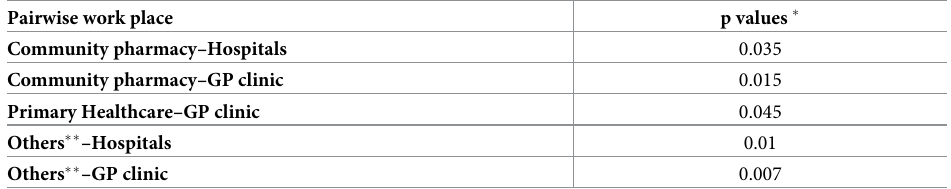
Table 3. Pairwise comparisons of work place regarding total attitude